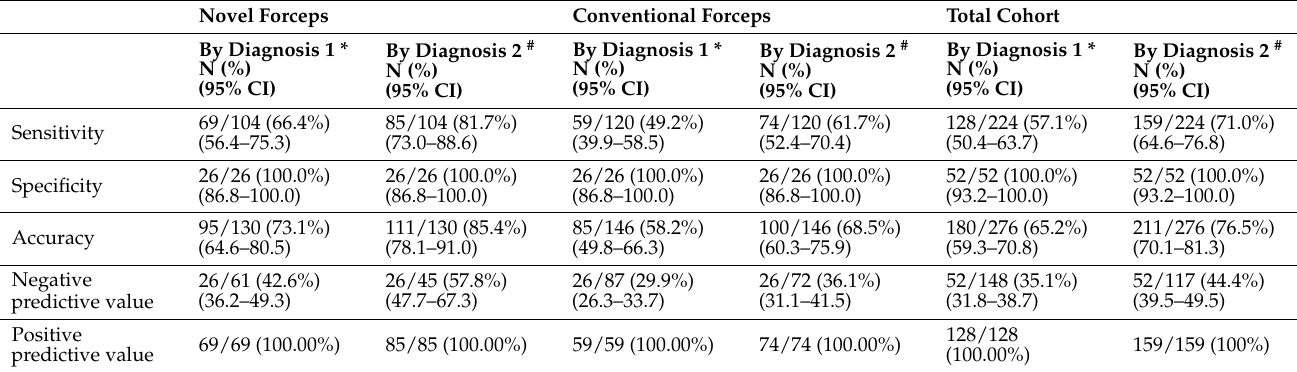
Table 2. Diagnostic performance of each of the forceps for endobiliary biopsies by diagnosis 1 * and 2 # .